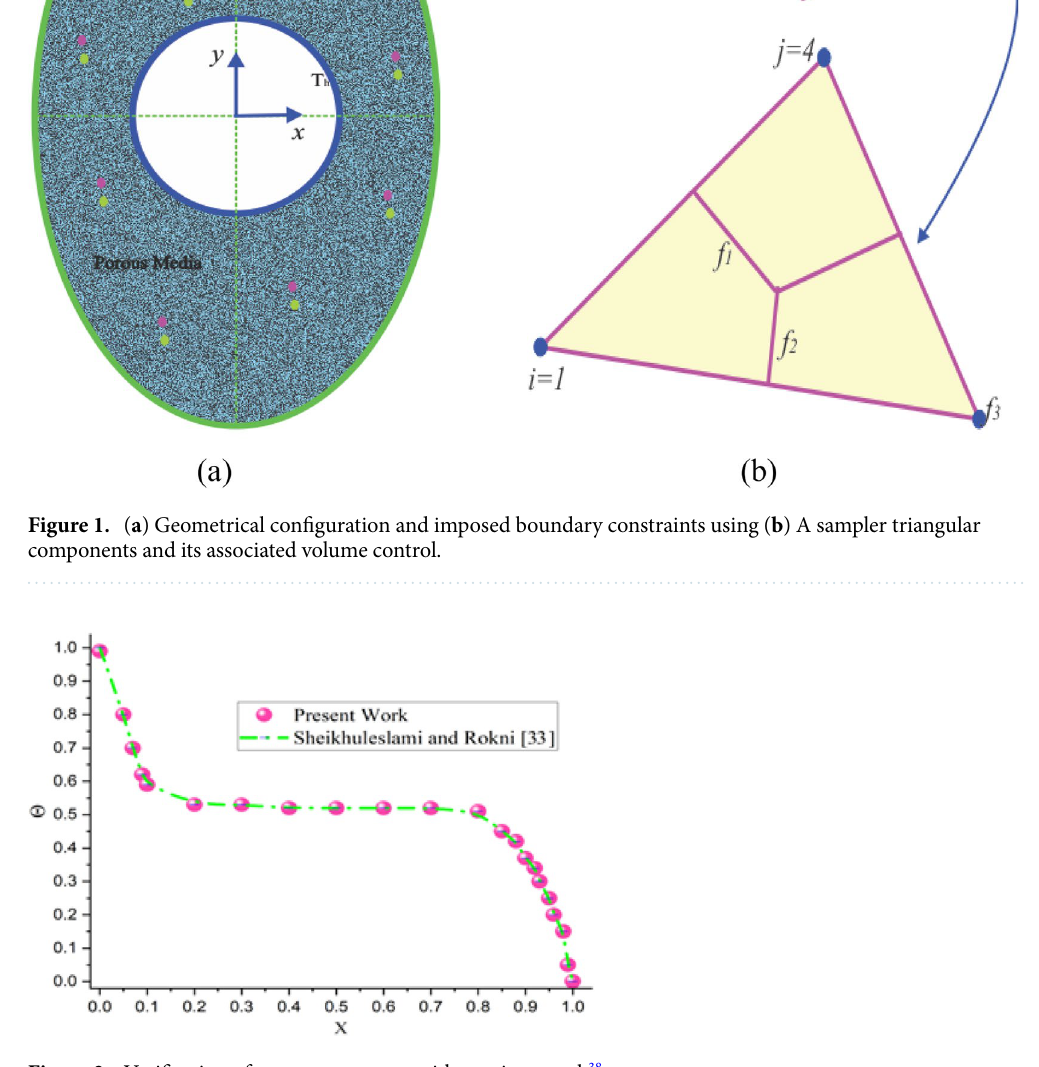
Figure 2. Verification of current outcomes with previous work 38